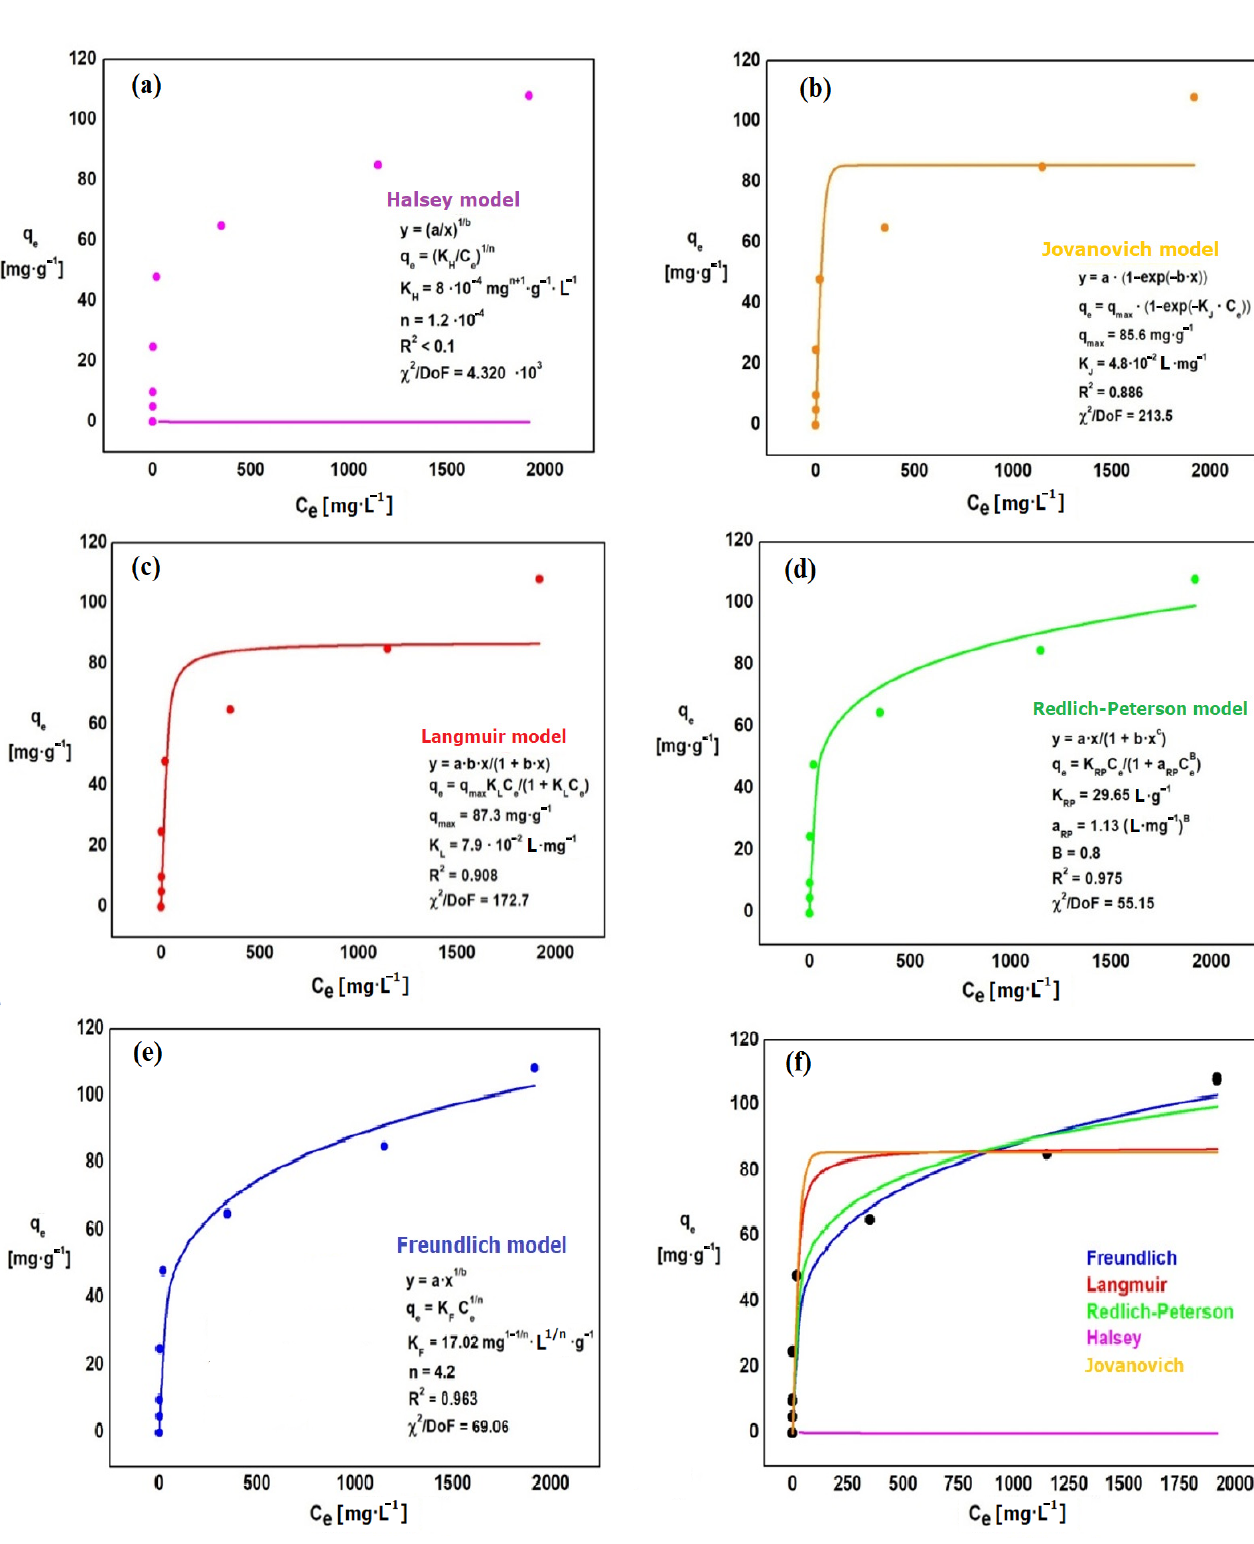
Figure 7. Isotherms: Halsey ( a ), Jovanovich ( b ), Langmuir ( c ), Redlich-Peterson ( d ), Freundlich ( e ), comparison of isothermal models for adsorbed chromates ions ( f ).